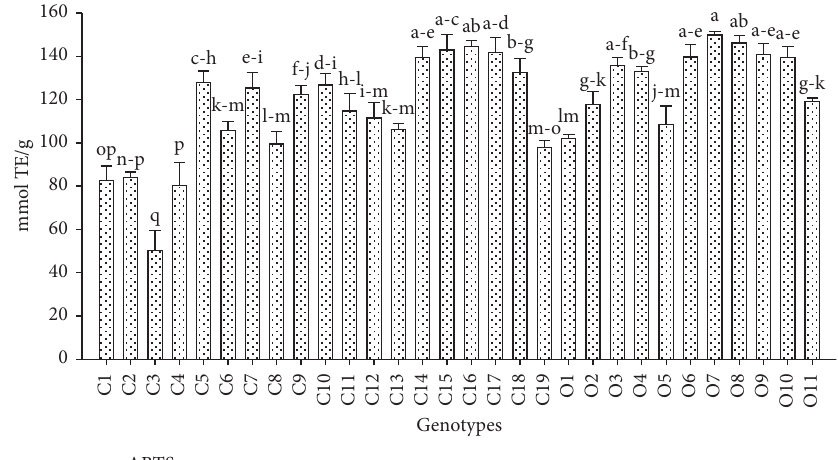
Figure 7: Variation of ABTS (2,2-azino-bis 3-ethylbenzothiazloine-6-sulphonic acid) radical scavenging.